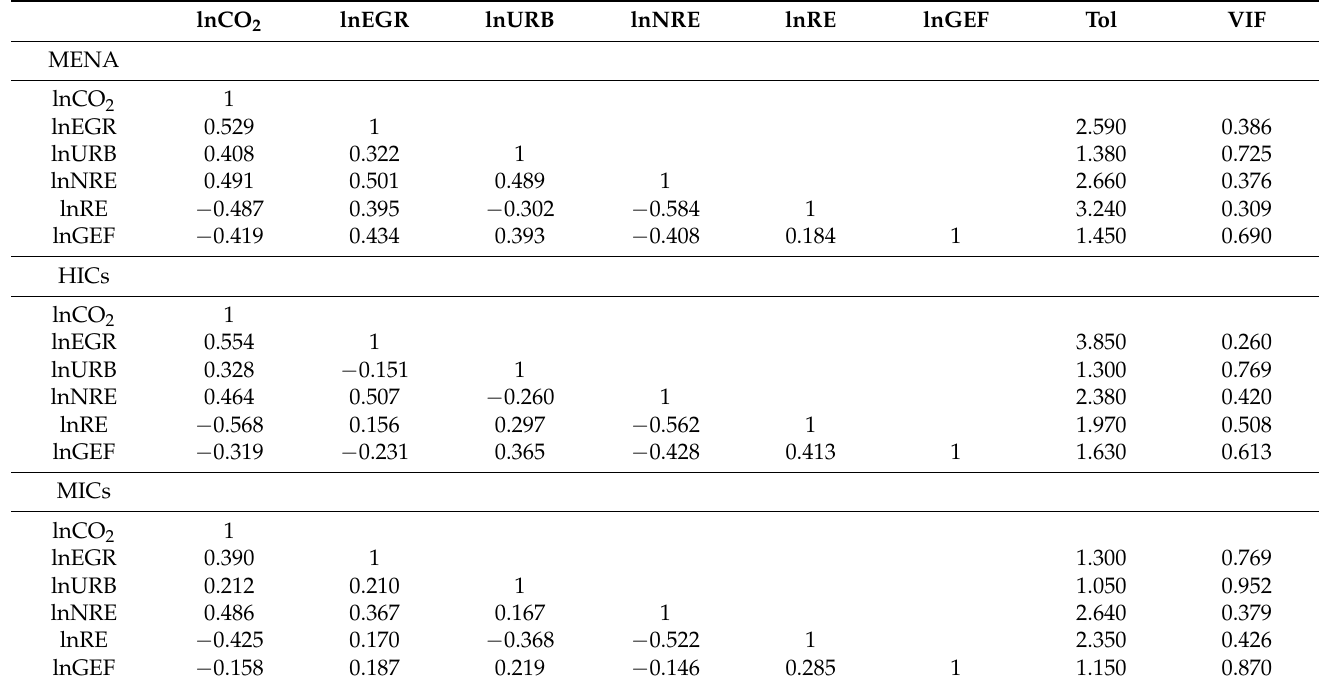
Table 4. Correlation and Multi-collinearity